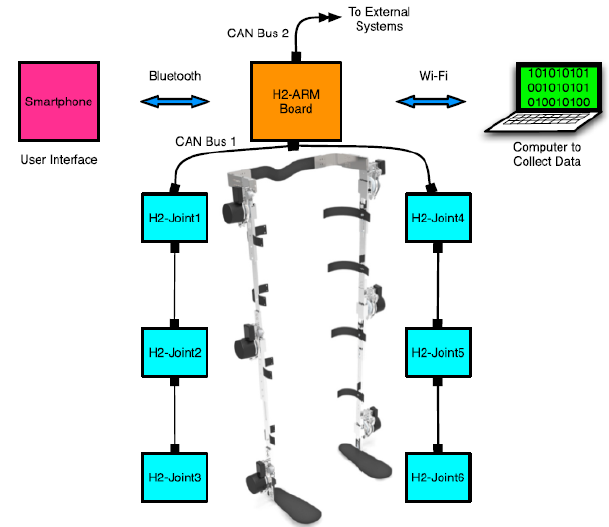
Figure 13. Control architecture of the H2 Exoskeleton